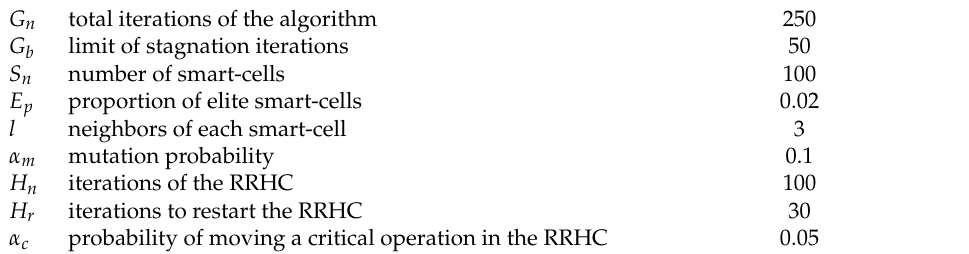
Table 2. Parameters selected for the execution of the